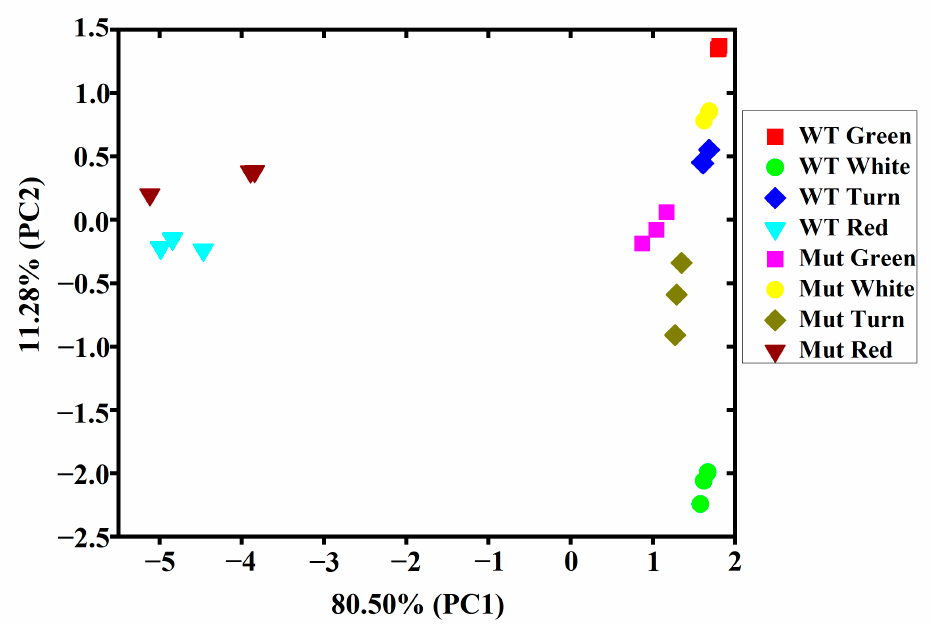
Figure 3. Principal component analysis of the contents of volatile components of ‘Sachinoka’ straw- berry and its somaclonal mutant ‘Mixue’ fruit at four developmental stages. WT represents cultivated strawberry ‘Sachinoka’. Mut represents somaclonal mutant ‘Mixue’.